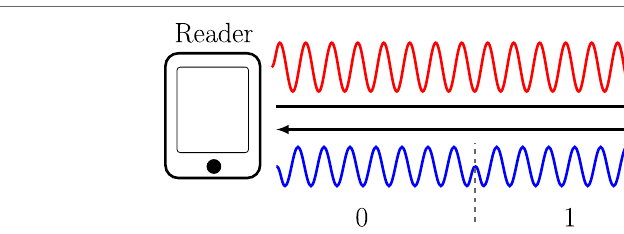
Fig. 3 The backward information-transmission mode of a BackCom link